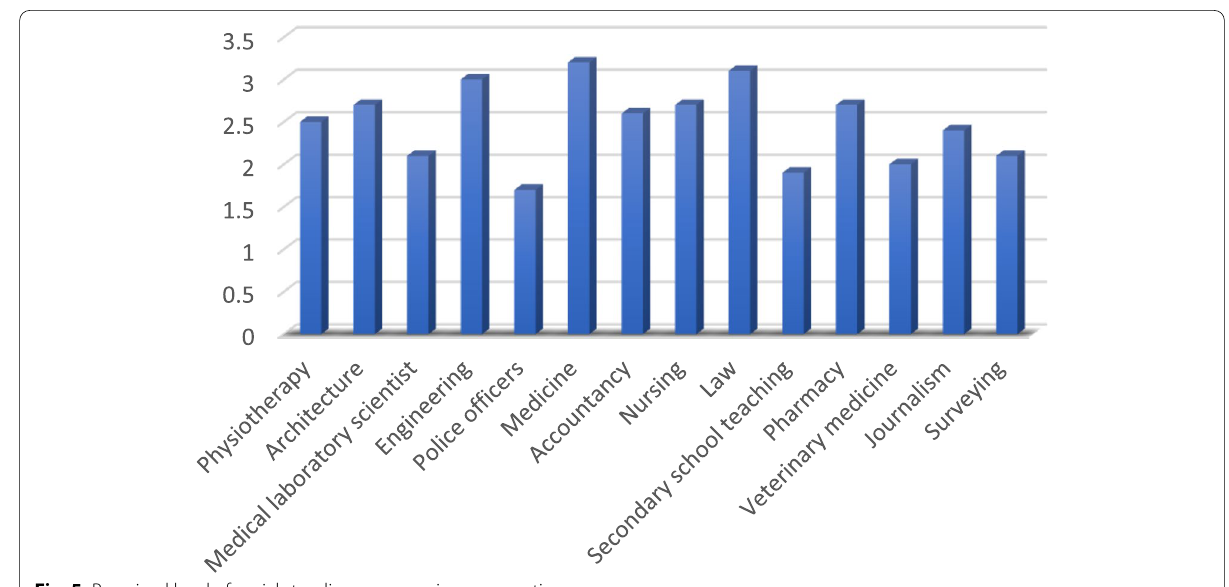
Fig. 5 Perceived level of social standing across various occupations